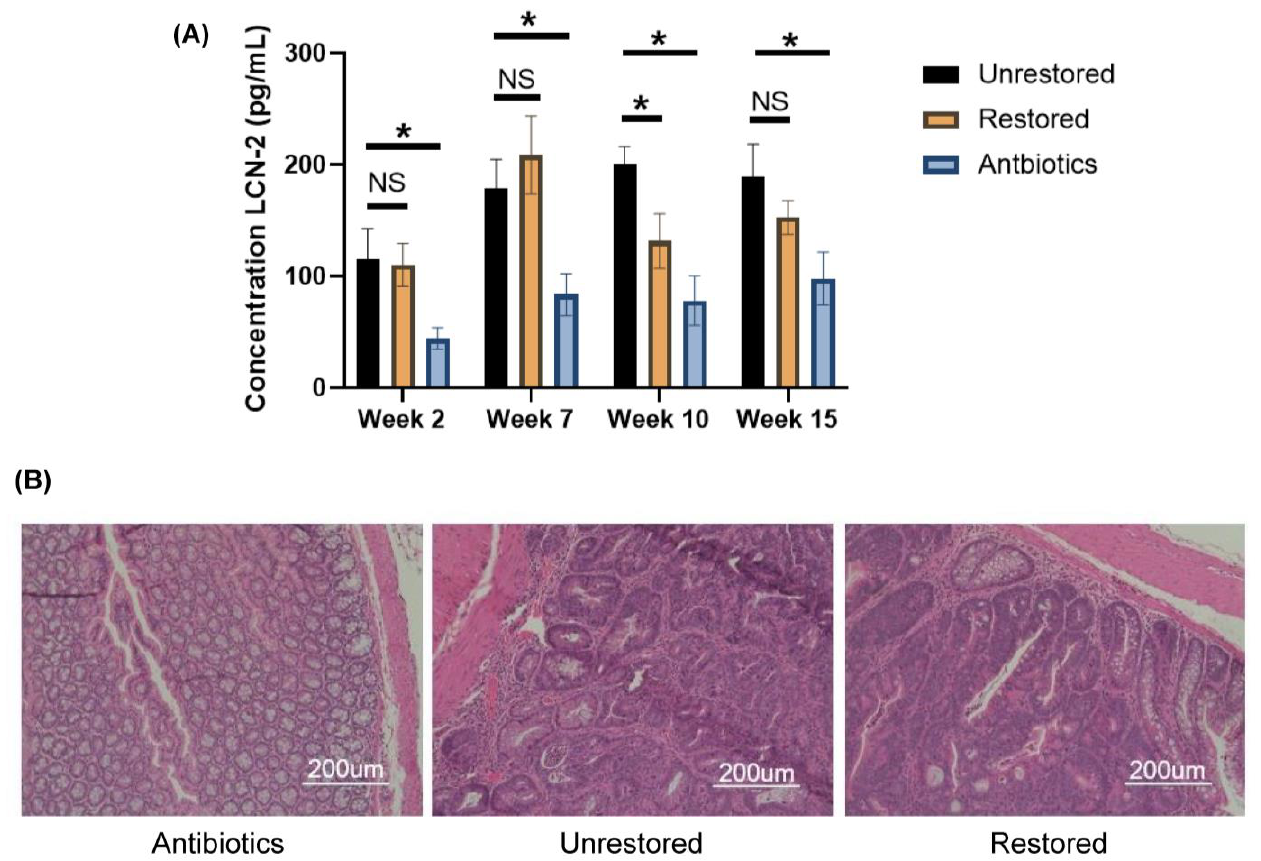
Figure 4. Fecal restoration modulates intestinal inflammation in C57BL/6 mice. ( A ) Fecal concentra- tions of Lcn-2 in unrestored (black), restored (orange), and antibiotics-treated mice (blue) in weeks 2, 7, 10, and 15 (left to right) (* p < 0.05) ( n = 3) (+/ − SD). (* p < 0.05) (NS p > 0.05) ( B ) Hematoxylin and eosin staining of the colon tissues of unrestored, antibiotics-treated, and restored C57BL/6 mice.